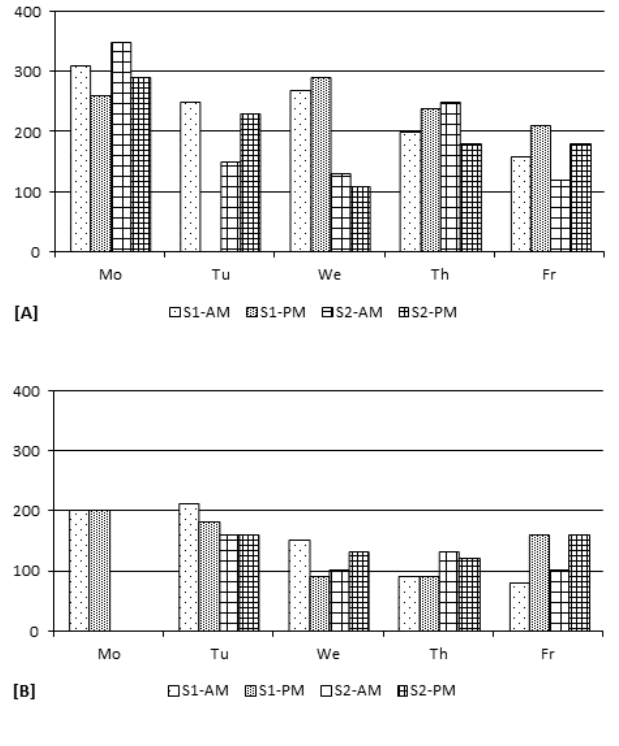
Figure 6. Concentrations (µg/m 3 ) of TCAM in the air of [A] and [B] in the morning (AM) and afternoon (PM) of each sampling day during S1 and S2 (Missing data were due to broken